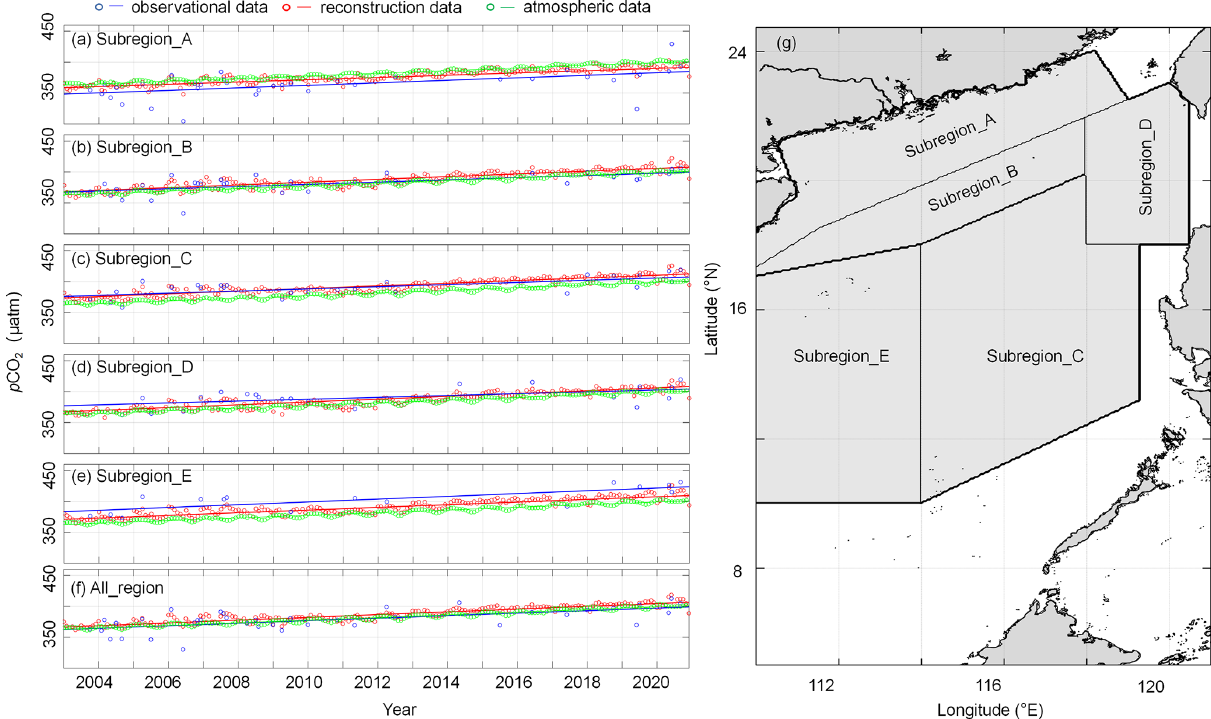
Figure 14. Time series of spatially averaged monthly p CO 2 data in five subregions (a–e) and the entire South China Sea (f) under study. The subregions are shown in panel (g) . The lines indicate the deseasonalized long-term trend of the spatially averaged monthly p CO 2 data for each subregion, with the slopes shown in Table 3. The deseasonalized method can be found in Landschützer et al.